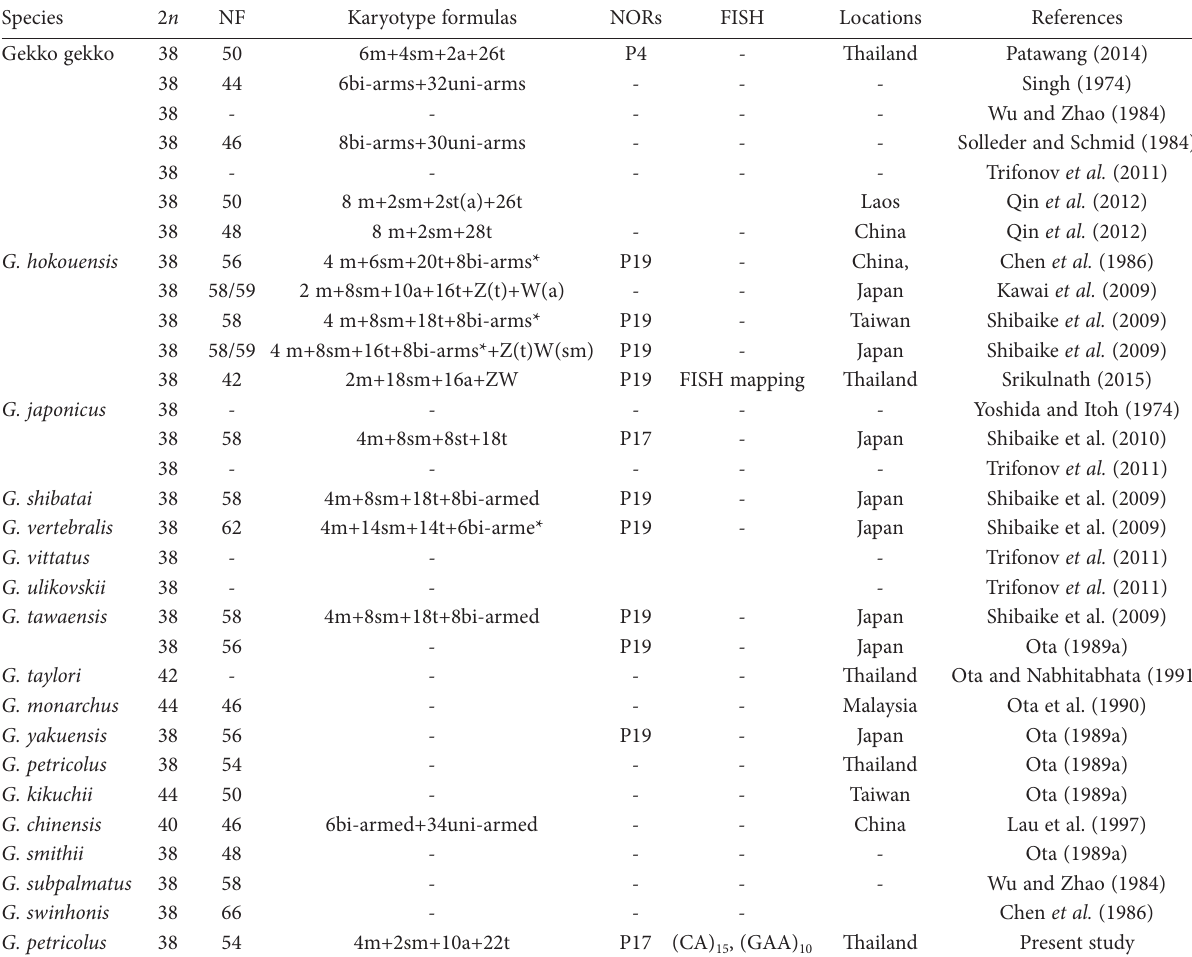
Table 1 The karyotype reviews among the genes Gekko (Gekkonidae, Squamata). Species 2 n